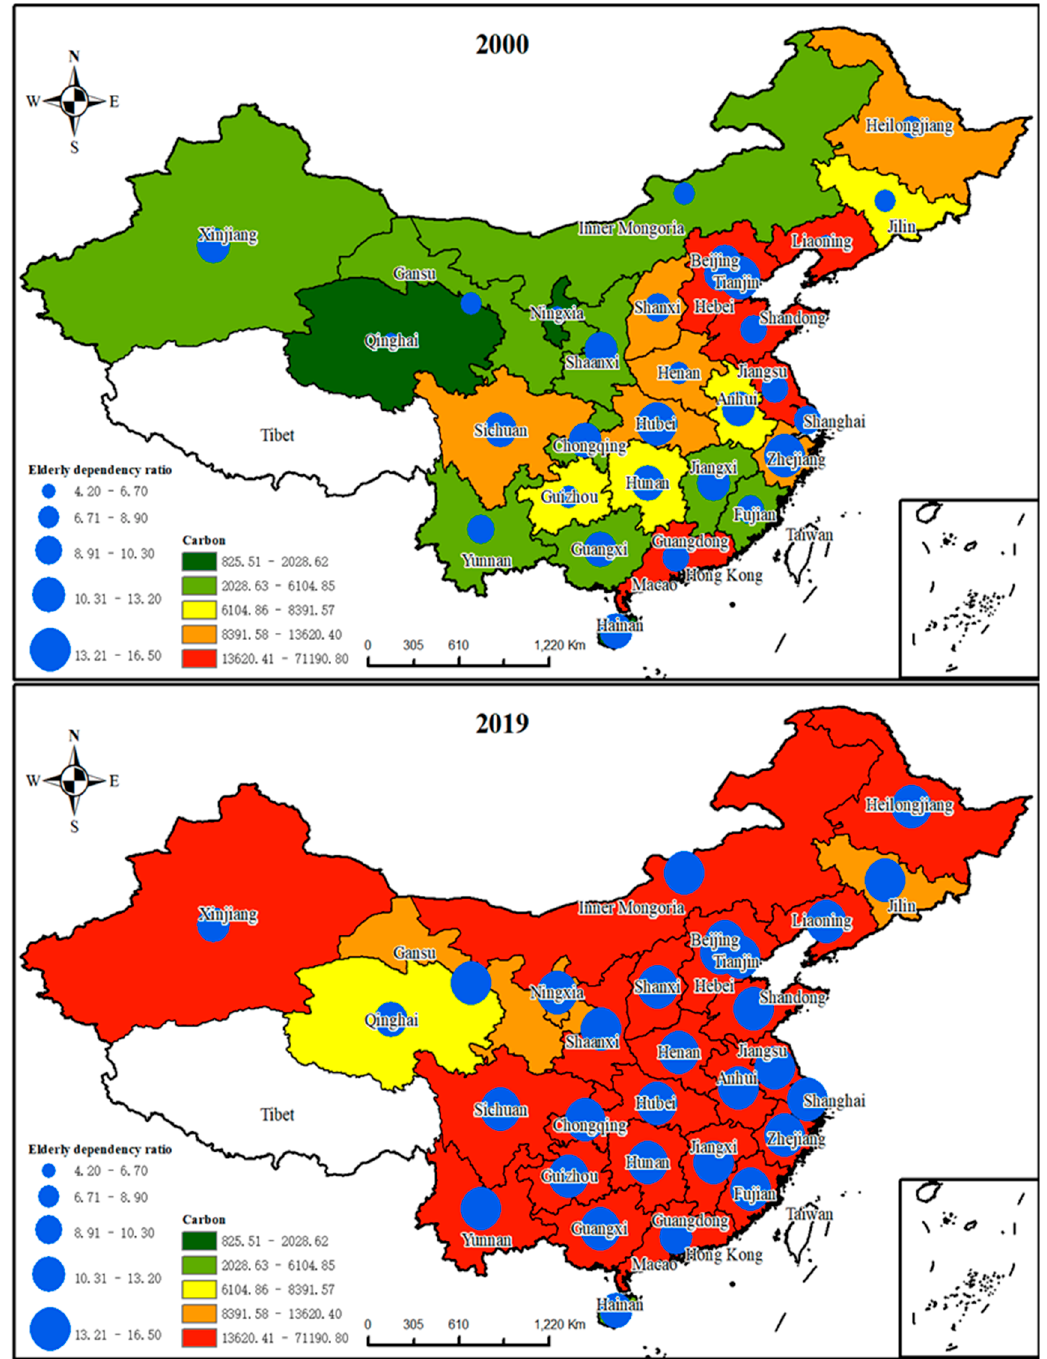
Figure 3. Carbon emissions and elderly dependency ratio by provincial administrative region in China in 2000 and